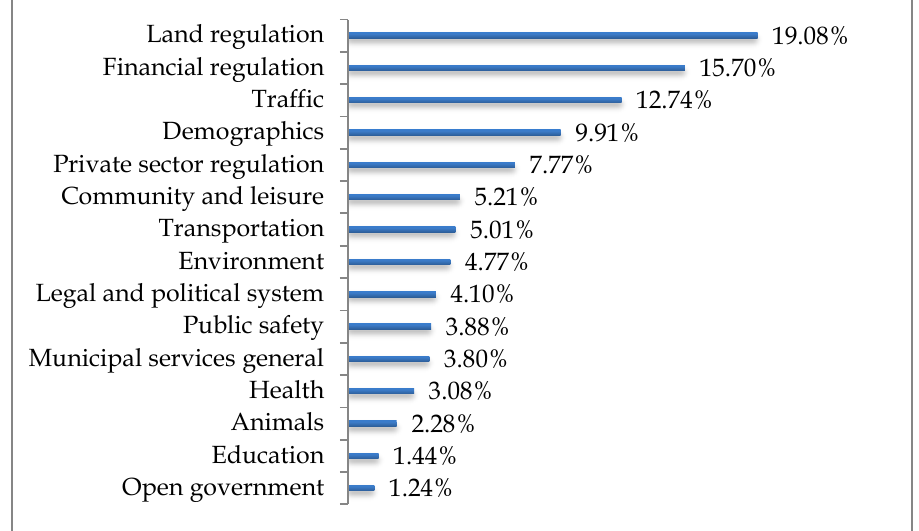
Figure 4: OGD Heartbeat